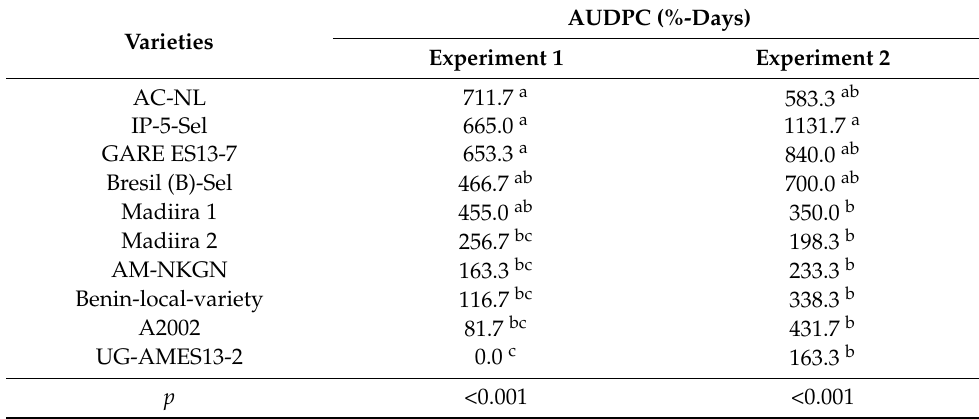
Table 3. Area under disease progress curve (AUDPC) of bacterial wilt incidence in the screen